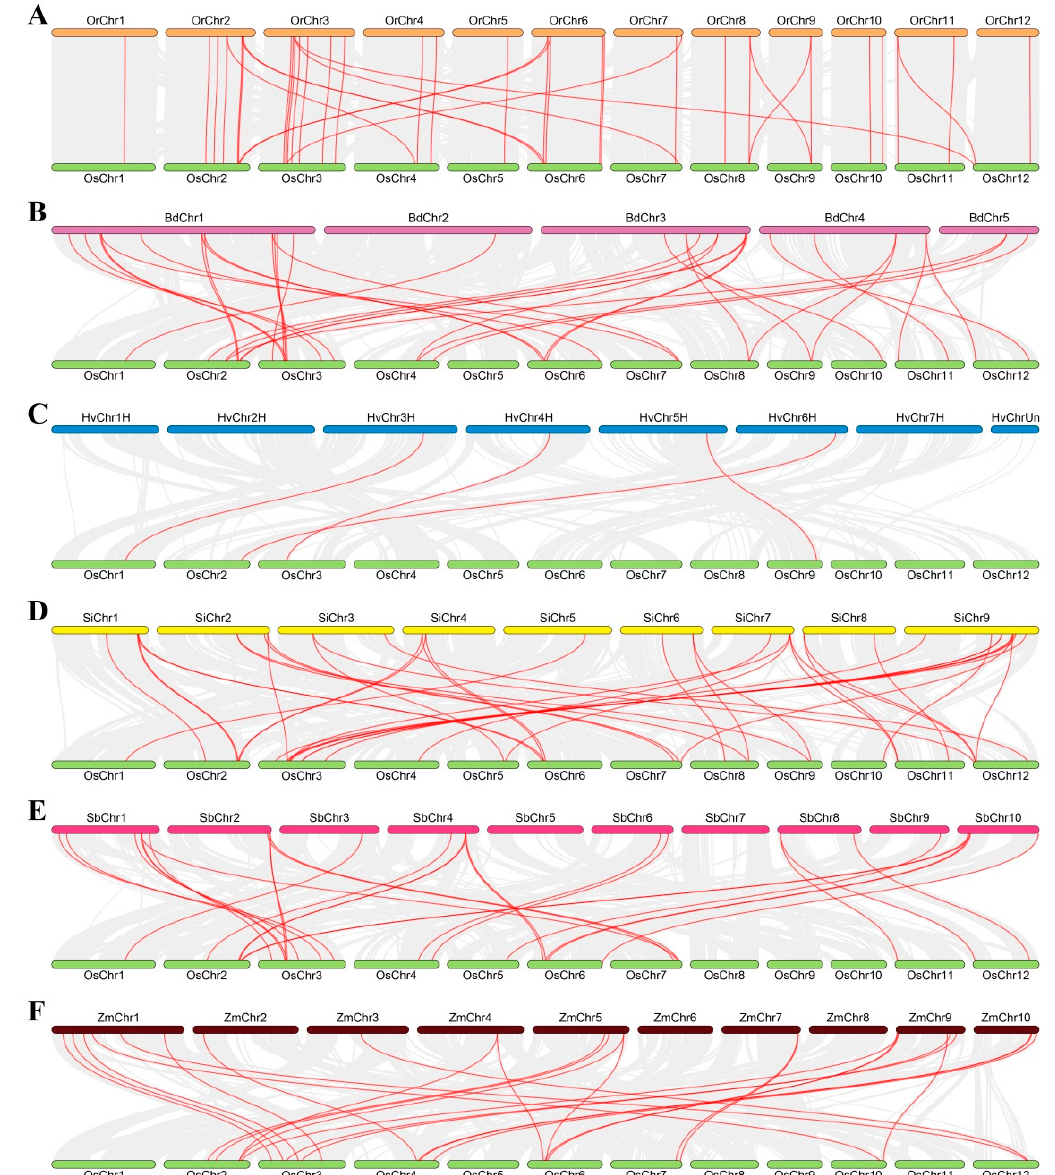
Figure 4. Collinearity relationships of GT8 genes in O. sativa ssp. japonica and O. rufipogon ( A ), B. distachyon ( B ), H. vulgare ( C ), S. italica ( D ), S. bicolor ( E ), and Z. mays ( F ), respectively.